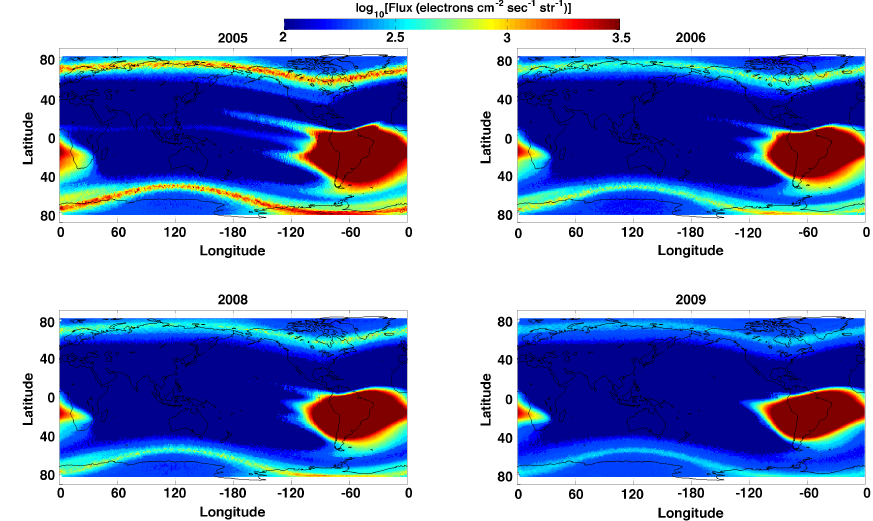
Fig. 1. World maps showing medians of > 30keV precipitating electrons observed by the 0 ◦ directed MEPED telescopes onboard POES in 2005, 2006, 2008 and